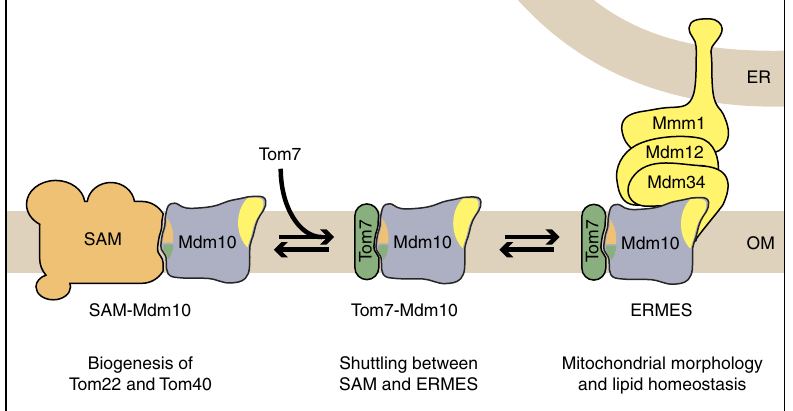
Figure 7 | Hypothetical model of the dynamic interaction of Mdm10 with partner proteins. Mdm10 interacts with SAM and ERMES via opposite surfaces of its b -barrel domain. Mdm10 forms an integral mitochondrial membrane anchor of ERMES and is required for ERMES functions in maintaining mitochondrial morphology and lipid homeostasis. SAM-bound Mdm10 promotes biogenesis of the TOM complex. The Mdm10-binding sites for Tom7 and SAM are in close proximity. Thus, Tom7 binds only to Mdm10 released from SAM and remains bound to Mdm10 in the ERMES complex. Not shown is the accessory subunit Gem1 that associates with ERMES in substoichiometric amounts. OM, outer mitochondrial